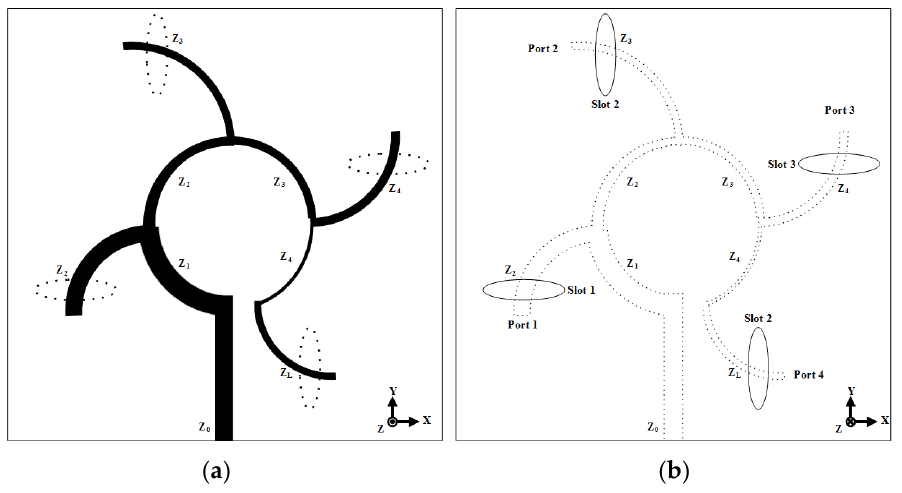
Figure 4. Configuration of the proposed array feed: ( a ) Front plane; ( b ) Bottom plane.